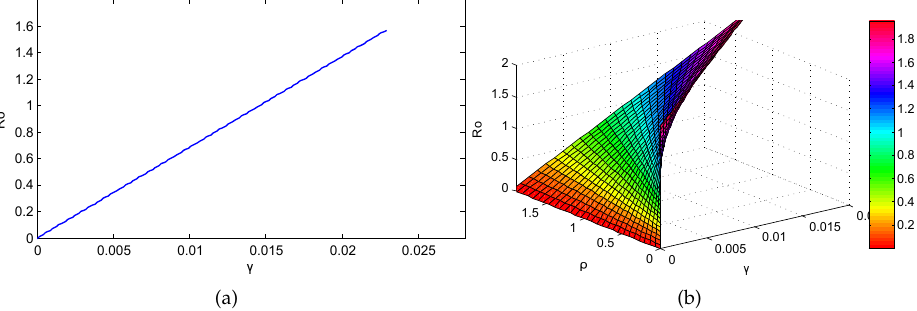
Figure 1. It is clear that, when R 0 < 1 , the model (3) has no endemic equilibrium and the disease-free equilibrium is stable. ( a ) Variation of R 0 with respect to the transmission rate γ . ( b ) Impact of γ and ρ on R 0